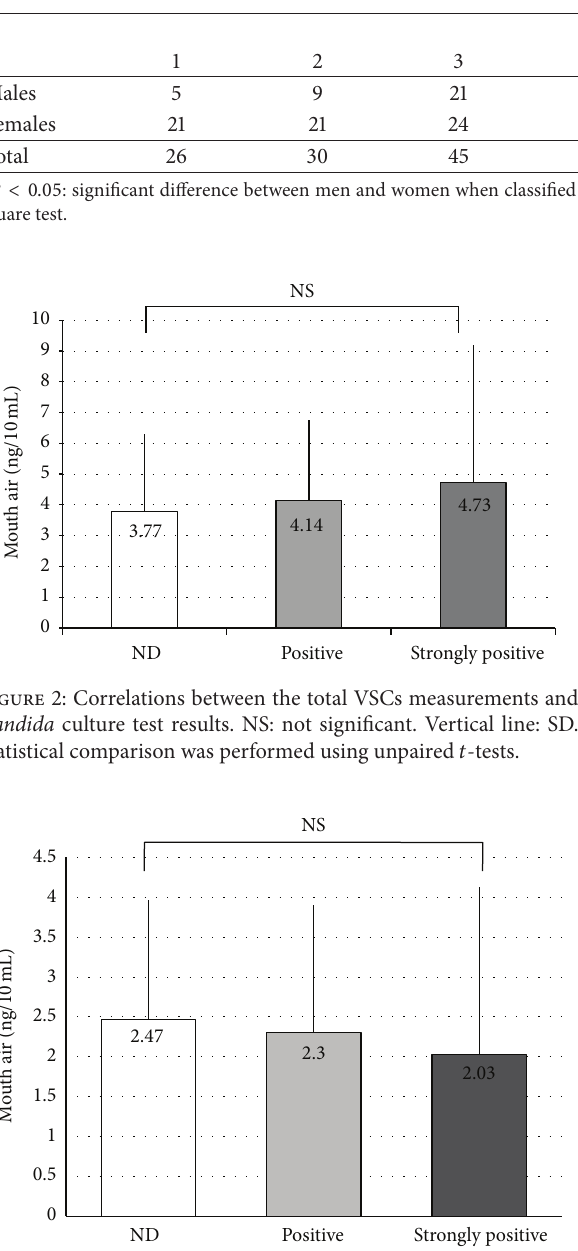
Figure 3: Correlations between the hydrogen sulfide measurements and Candida culture test results. NS: not significant. Vertical line: SD. Statistical comparison was performed using unpaired 𝑡 -tests.